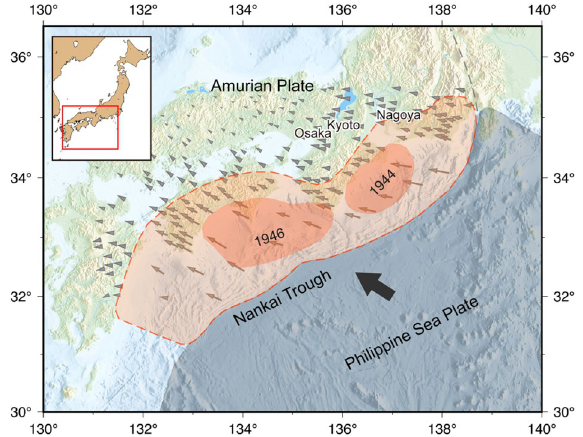
Figure 1. Tectonic setting of the Nankai Trough megathrust. The grey area indicates the Philippine Sea Plate. The thick arrow indicates the plate convergence direction. The grey arrows indicate ground displacements 12 . The light orange area corresponds to the maximum-possible fault area published by the Japanese